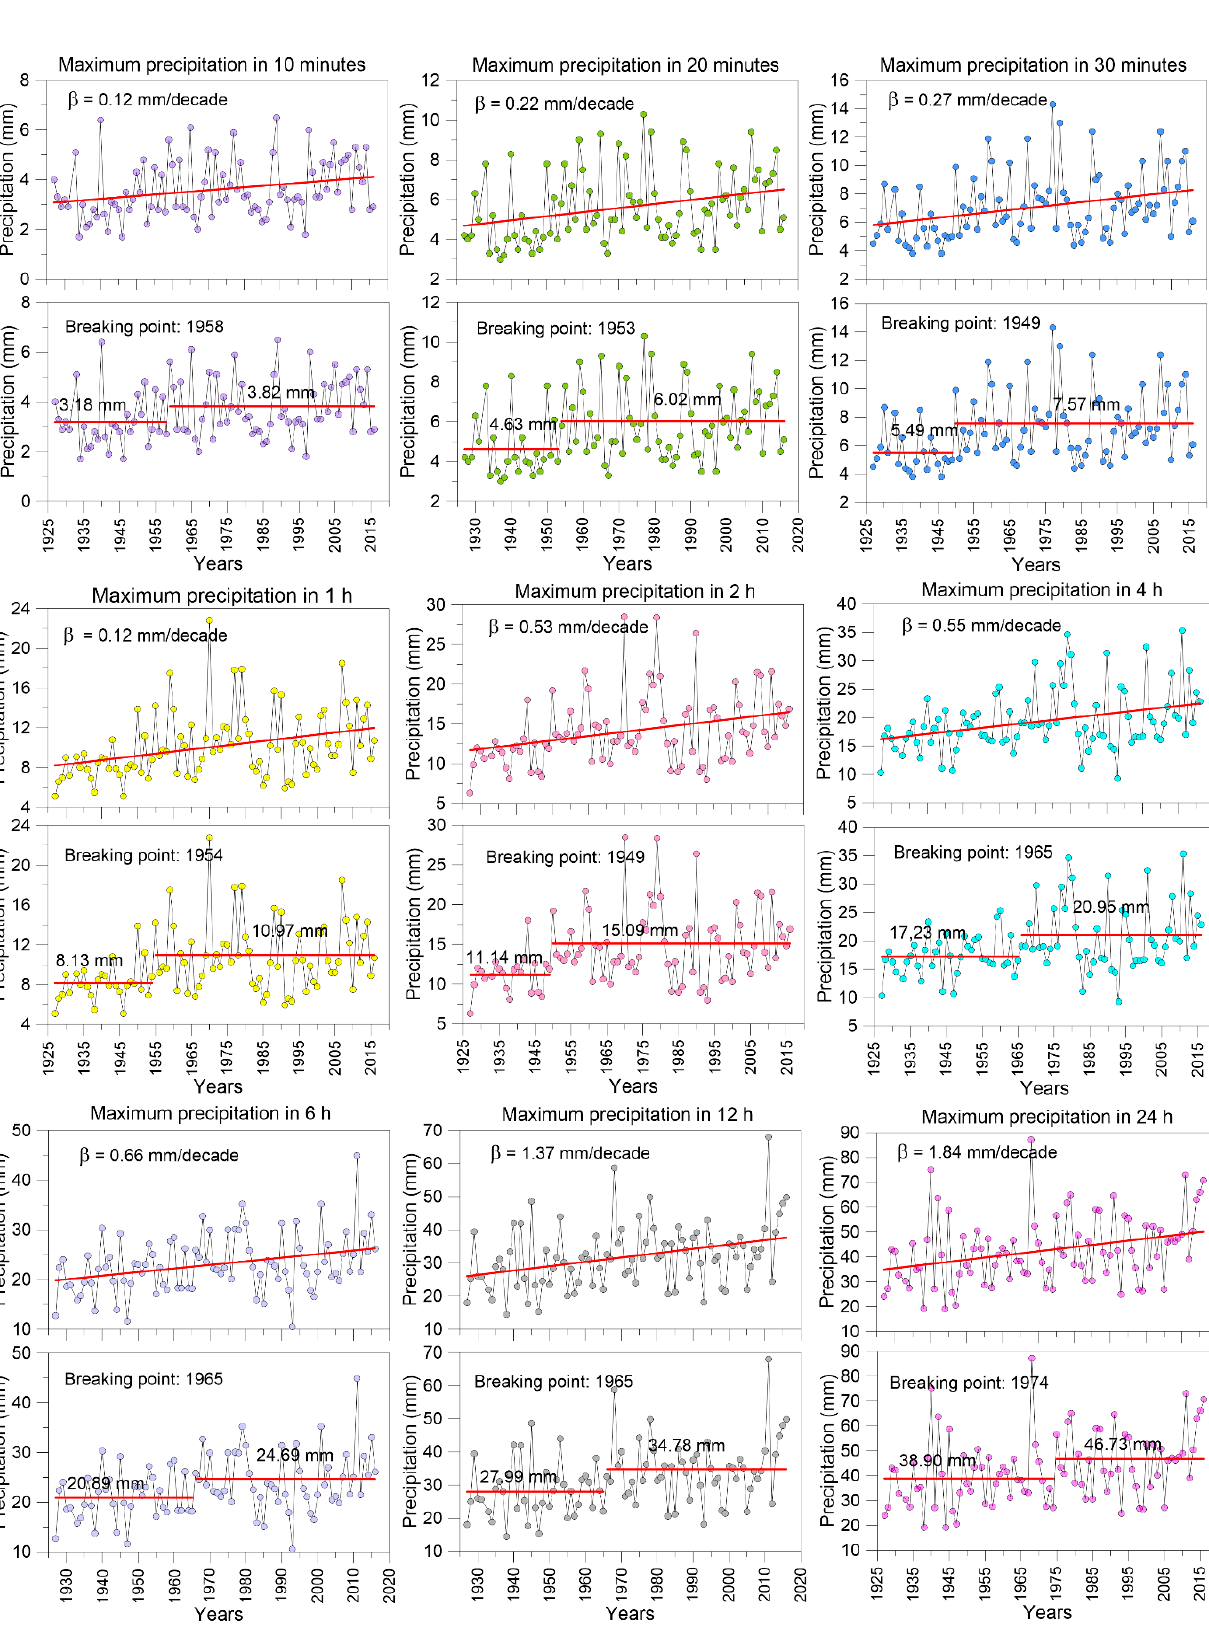
Figure 4. Representation of the trends according to Mann–Kendall and the breaking points estimated with the Pettitt test for all the maximum precipitation intensities in the winter season. In the graphs for each duration, the Mann-Kendall trends (up) are plotted with the value of the Senn slope ( β ). The Pettit test plots (down) show the change point and the precipitation averages for each period.